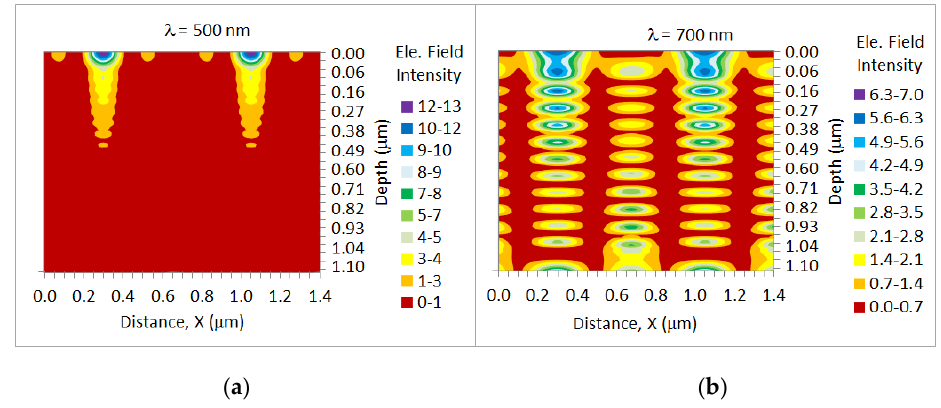
Figure 7. Electric field intensity distribution across the silicon absorber layer at an incident wavelength of ( a ) 500 nm and ( b ) 700 nm for the dual-grating cell with optimized parameters for the front and rear nano-cone arrays. The incident electric field intensity is normalized to 1.